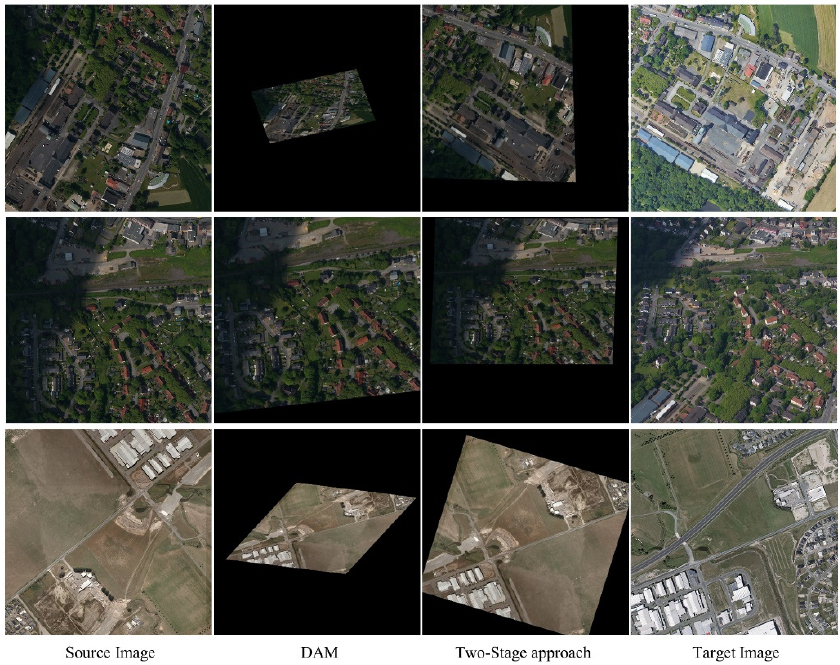
Figure 17. The registration results of images in ISPRS [51] ( Row 1 and 2 ) and WHU [52] ( Row 3 ).